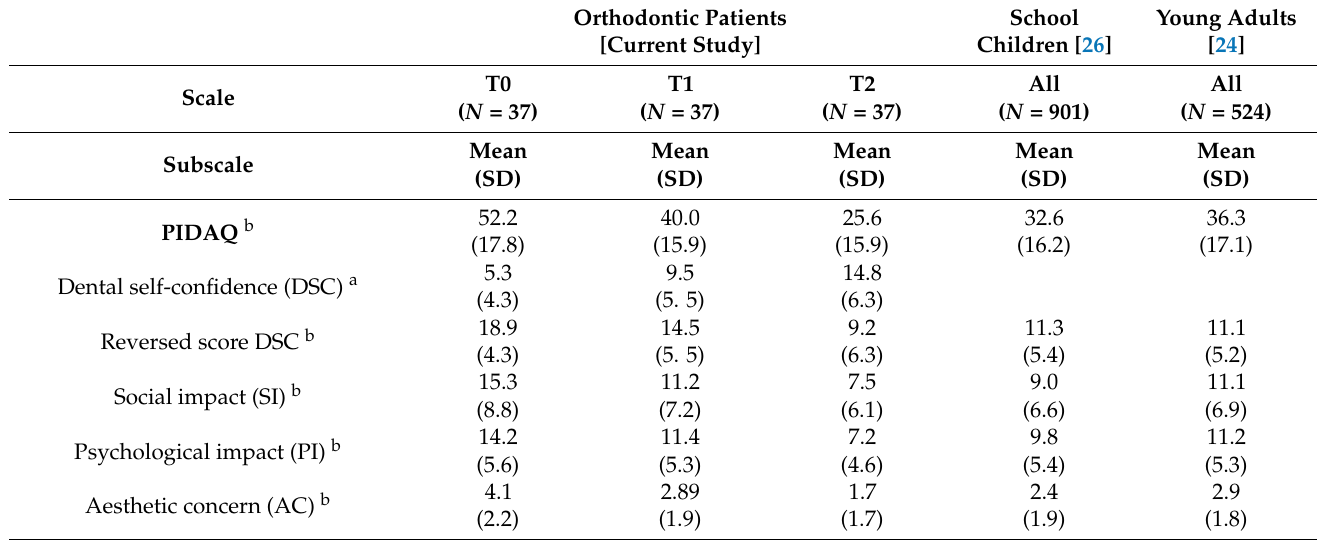
Table A1. Psychosocial impact of dental aesthetic questionnaire (PIDAQ) scores of Malaysian